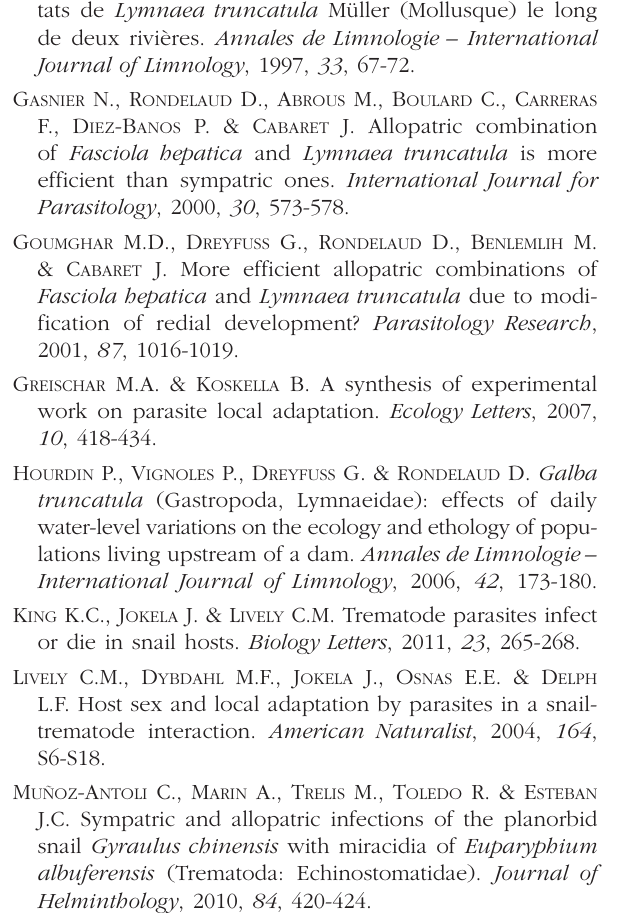
Table III. – Number of shedding waves noted during the patent period in the snail groups from Ruffec/Saint-Gaultier and Thenay.